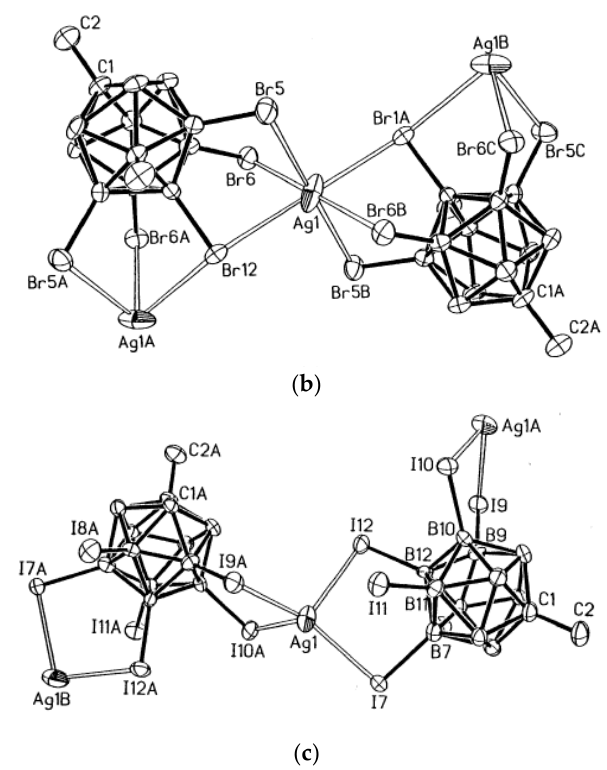
Figure 71. Fragments of X-ray structure of {Ag( η 1 -mesitylene)[1-Me-1-CB 11 H 5 -6,7,8,9,10,11,12-Cl 6 ]} n ( a ), {Ag[1-Me-CB 11 H 5 -6,7,8,9,10,11,12-Br 6 ]} n ( b ) and {Ag[1-Me-1-CB 11 H 5 -6,7,8,9,10,11,12-I 6 ]} n ( c ). Reproduced with permission from reference [89]. Copyright © (1999) Elsevier.